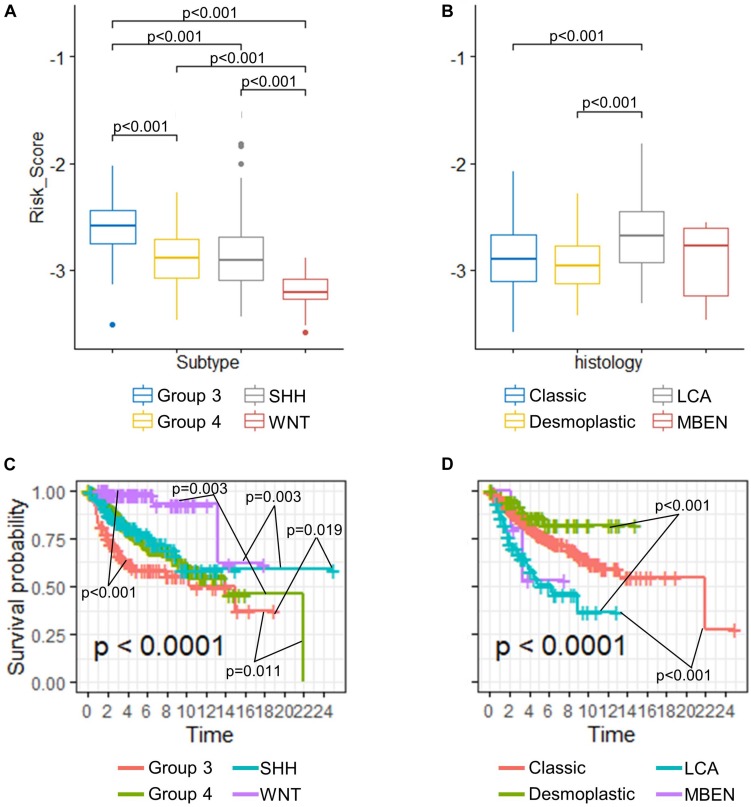
Comparison of risk scores in different (A) molecular subgroups and (B) histological subtypes (Kruskal–Wallis H test followed by Dunn’s post hoc tests for pairwise comparisons). K–M curves of different (C) molecular subgroups and (D) histological subtypes (P-values were calculated using “survminer” and were adjusted using the BH method).